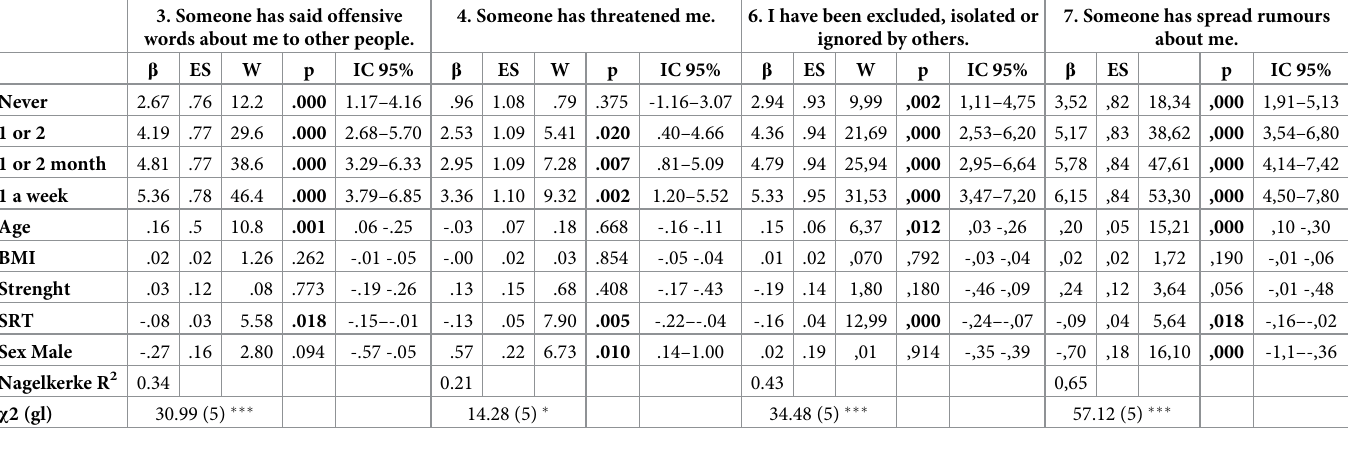
Table 7. Ordinal regression analysis with age, height, weight, Strength Cardiorespiratory fitness and gender, as cross-sectional predictors of victimisation behaviours.